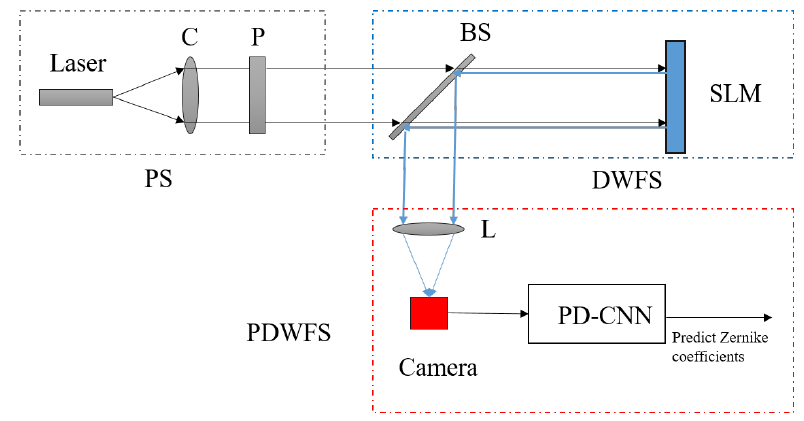
Figure 1. The experimental optical system for generating data sets.